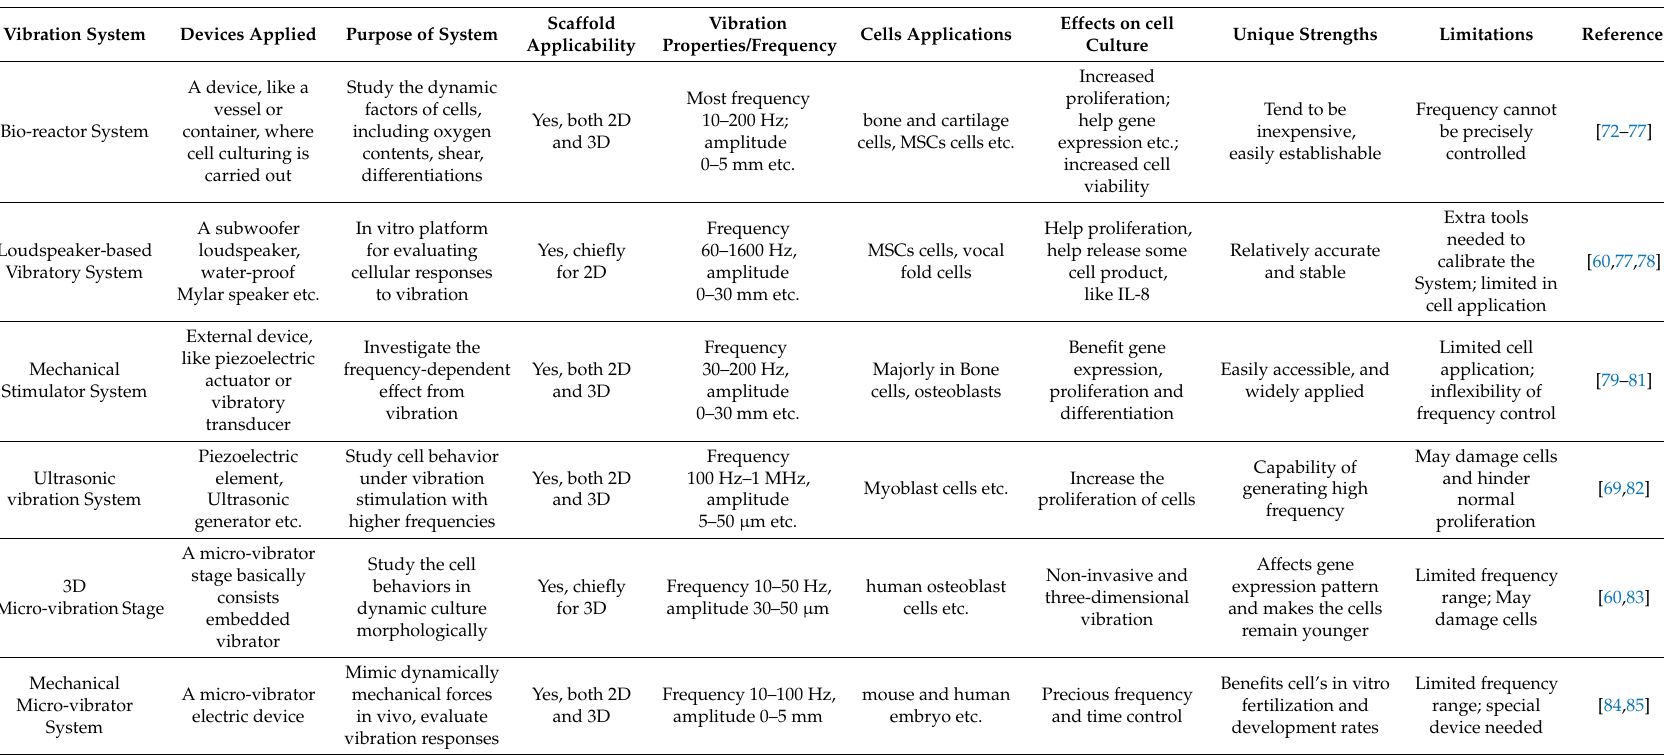
Table 2. Previously applied vibration mechanisms on cell cultivation and illustration of their functions and